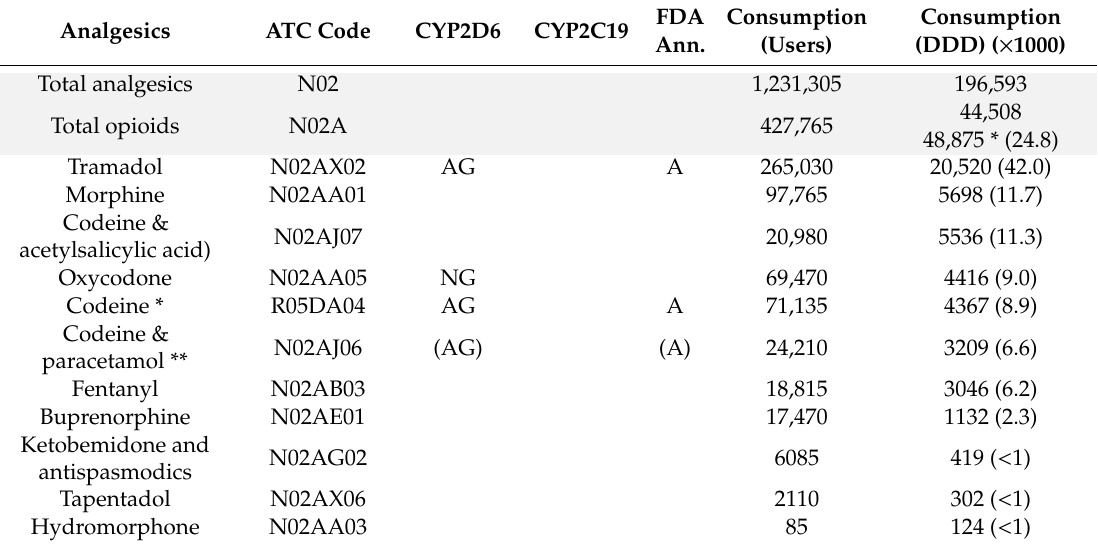
Table 2. Consumption of